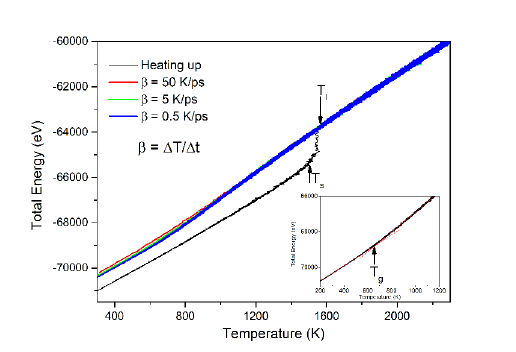
Zr Ti 60.0 32.5 7.5